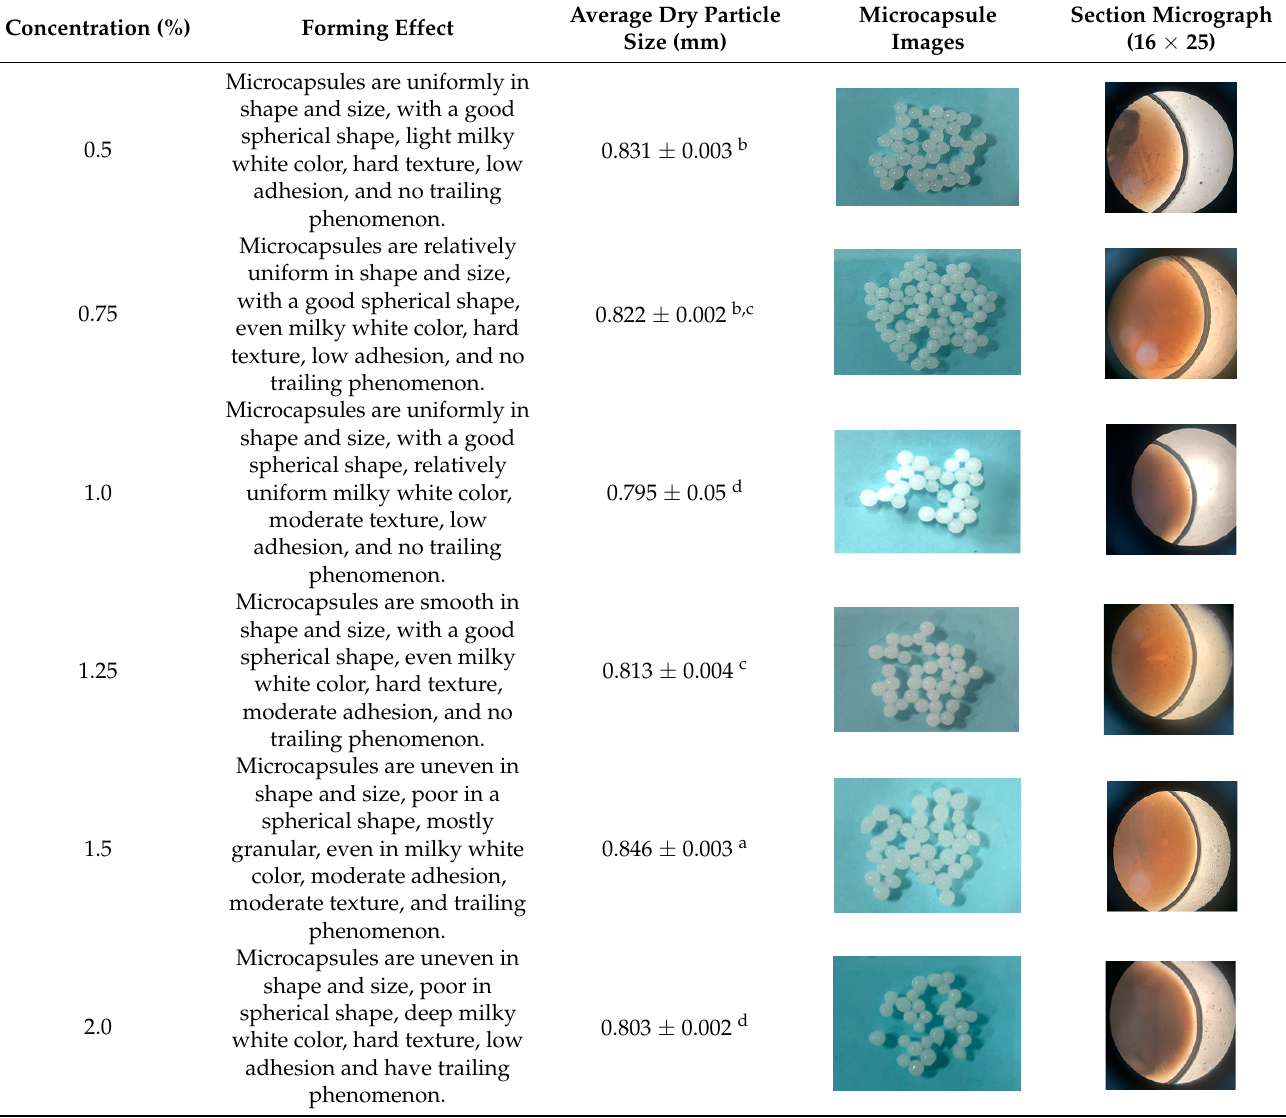
Table 4. Effect of CS concentration on microcapsule formation.